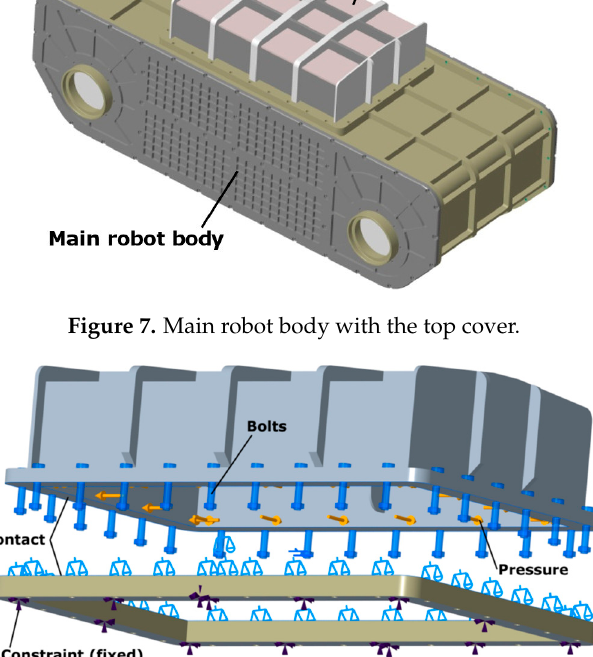
Figure 7. Main robot body with the top cover.